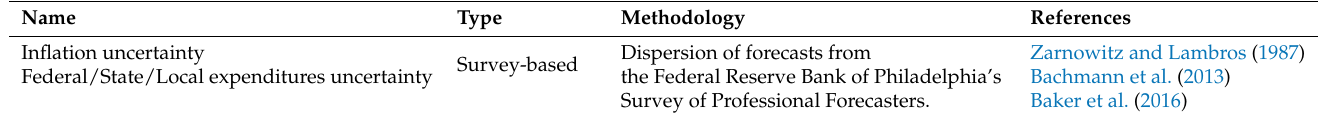
Table 9. List of uncertainty measures considered in this